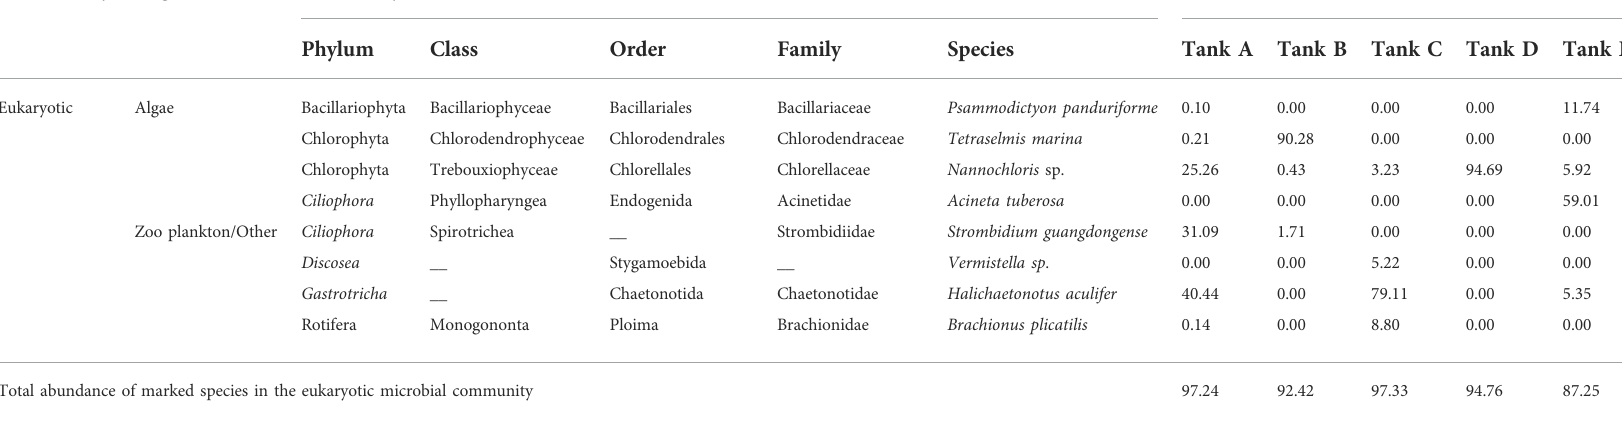
TABLE 2 Taxonomy and relative abundance of predominant strains in eukaryotic and prokaryotic microbial communities from the fi ve tanks at the studied Litopenaeus vannamei shrimp farms. Community